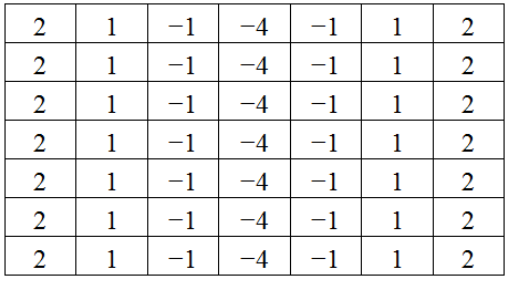
Figure 28. Modified filter with size of 7 × 7.